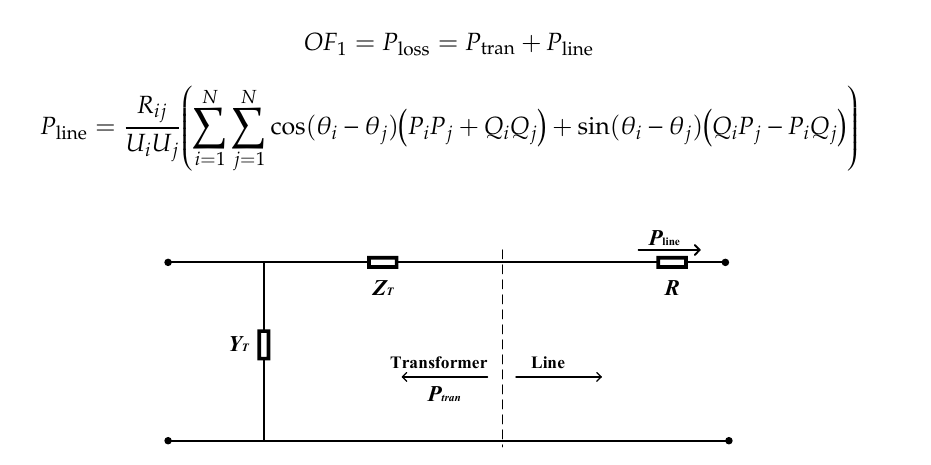
Figure 1. The equivalent models of transformer and line.